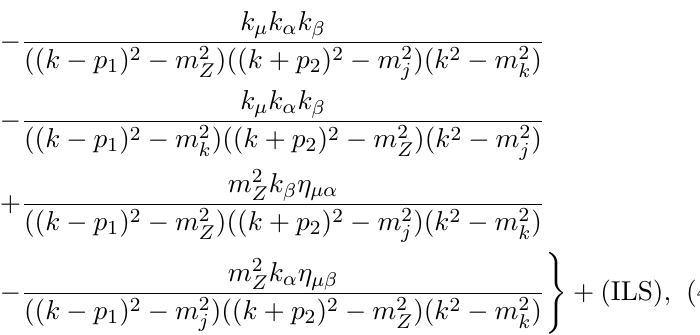
Figure 6 . Scatter plots showing the absolute value of the CP violating form factor f Z values of q 2 for points in the parameter space of the type-1 C2HDM satisfying theoretical (unitar- ity, bounded from below) and experimental (LHC Higgs, electric dipole moments, and electroweak p precision measurements)